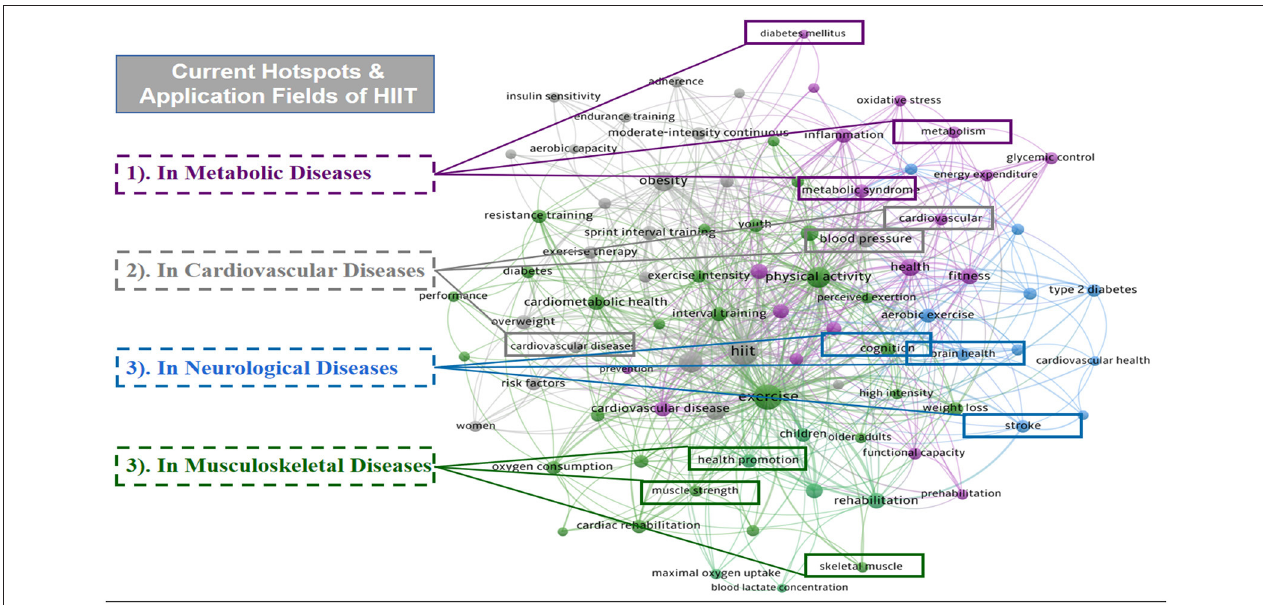
FIGURE 7 | The distribution of the co-occurrence network of keywords in the HIIT-HP